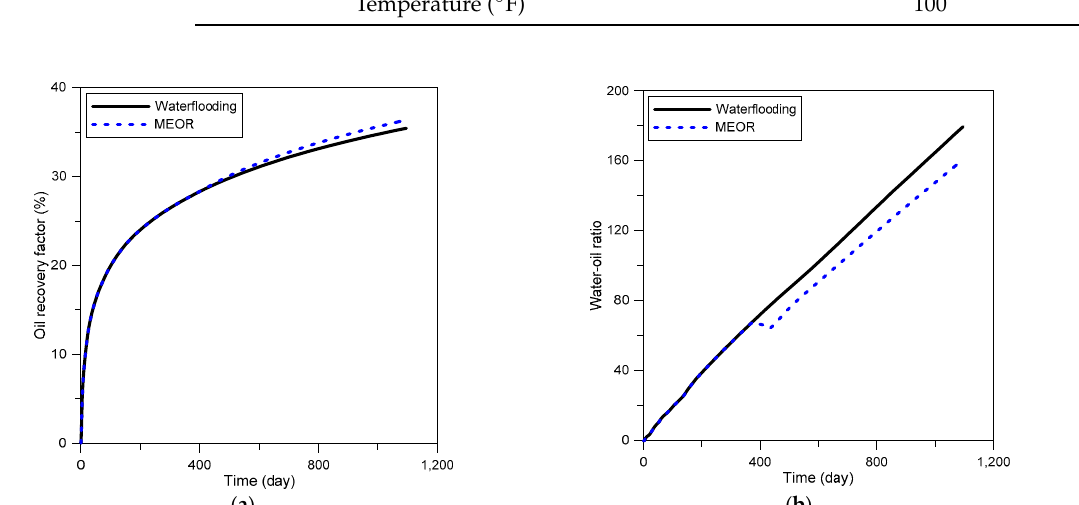
Figure 6. Improvements of recovery efficiency by MEOR in field applications: ( a ) recovery factor, ( b ) water-oil ratio.